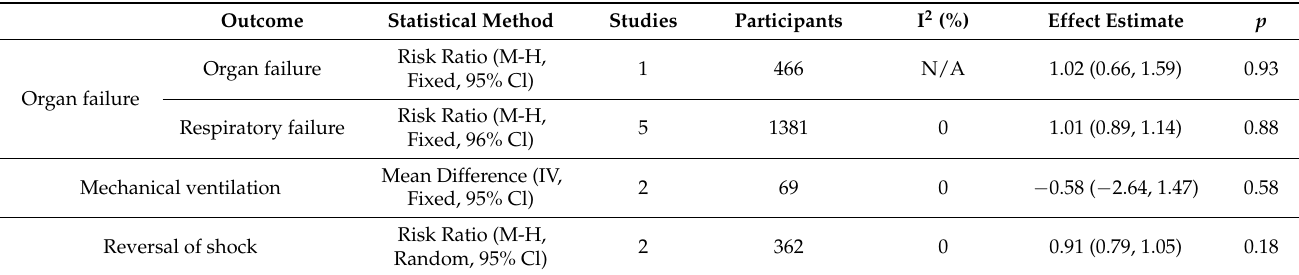
Figure 3. Forest plot of length of stay in hospital and ICU. Table 2. The corticosteroid impact on other clinical outcomes in sepsis